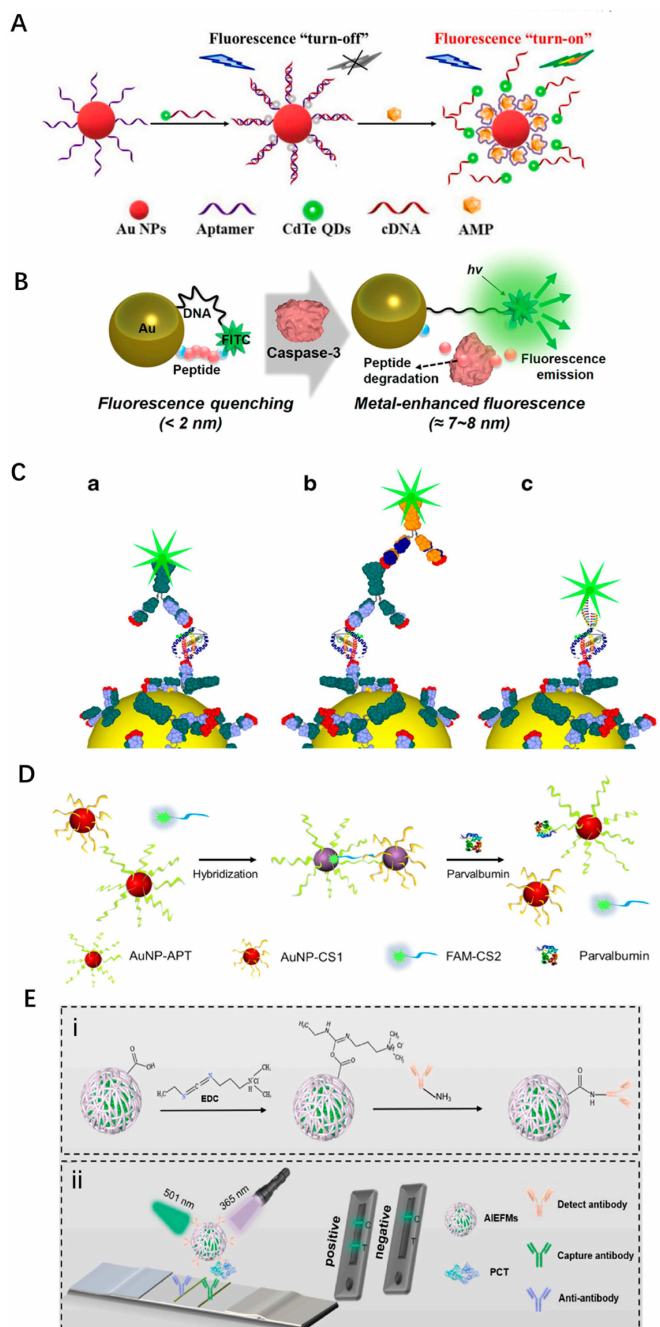
Figure 4. Fluorometric Apta-biosensing methods based on AuNPs. ( A ) A turn-on fluorescent aptasen- sor for AMP detection, reproduced with permission from [49]. Copyright 2022 Microchemical